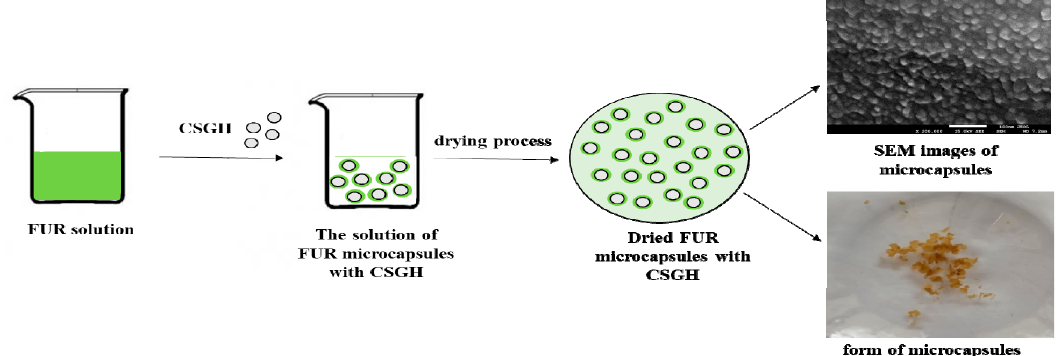
Figure 1. Scheme of furcellaran (FUR) microcapsules with carp skin gelatine hydrolysate (CSGH) formation.